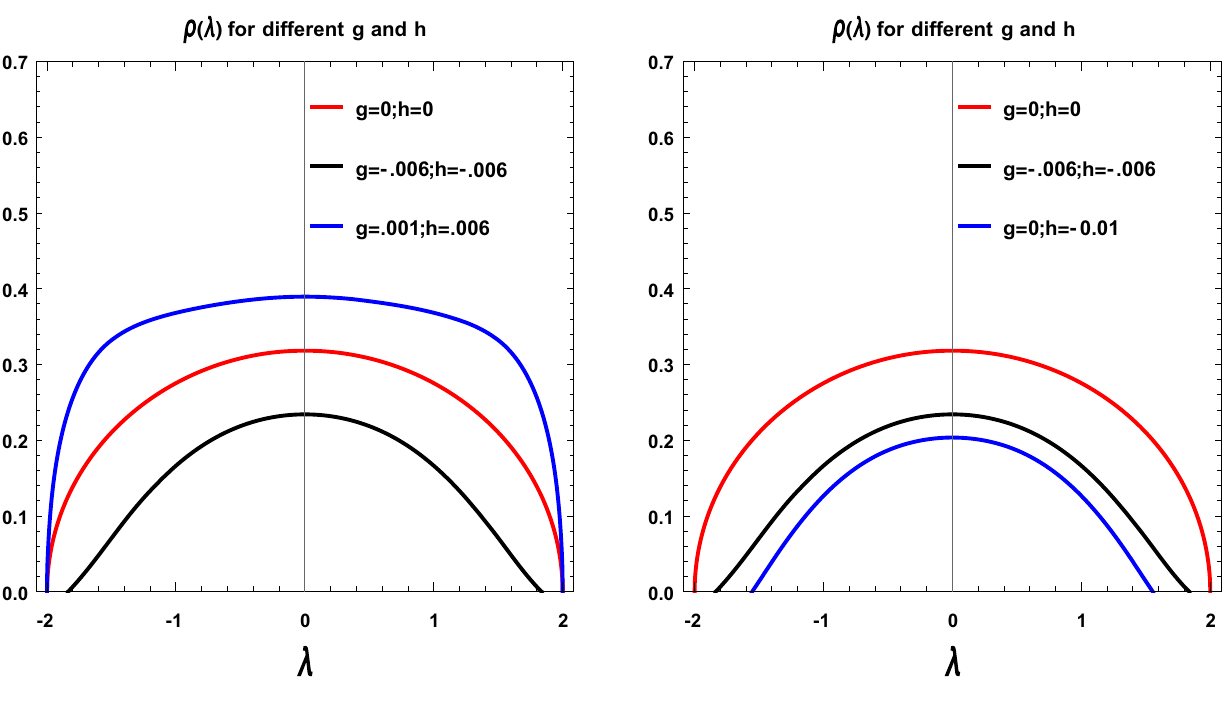
(b) ρ ( λ ) for sextic potential for different g, h . Fig. 28 Eigen value distribution curve of density function for sextic potential for different parameter values. Here we fix a =